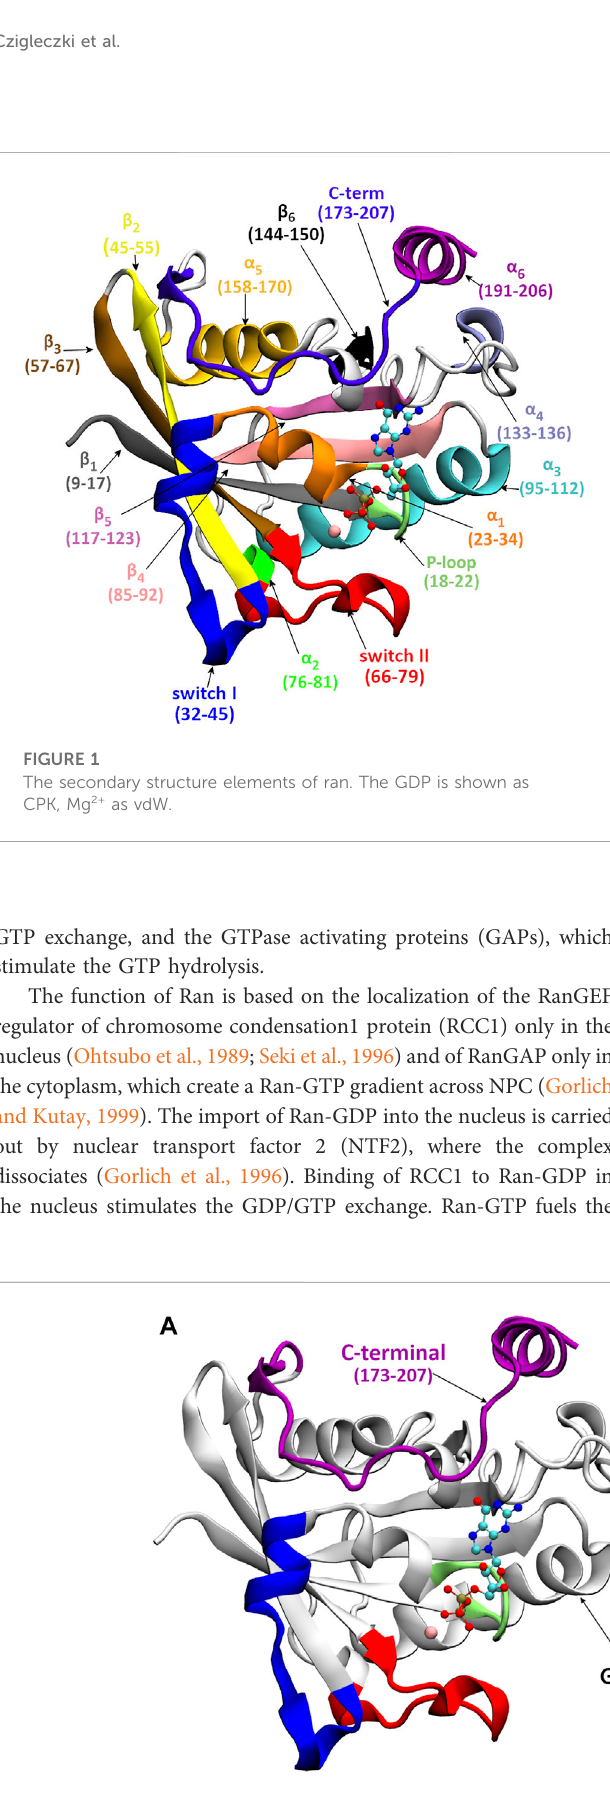
The crystal structure of Ran-GDP (A) and Ran-GTP (B) . Different structural elements are color coded: P-loop (lime), switch I (blue), switch II (red), C-terminal (purple), the GDP/GTP is denoted by CPK, Mg 2+ by pink